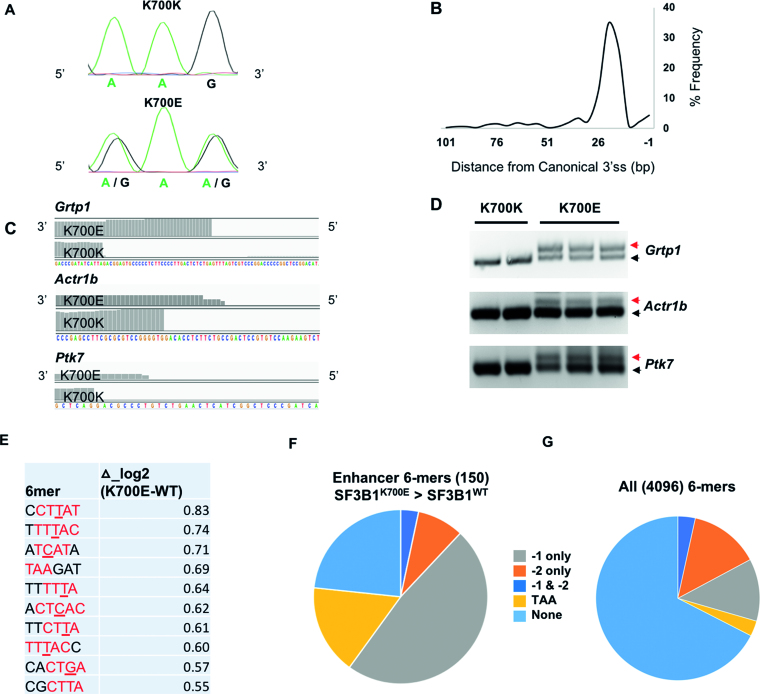
Generation of isogenic Sf3b1-mutant mouse embryonic stem cells (mESC) and confirmation of changes to BP usage. (A) Analysis of SF3B1 mRNA expression from edited alleles by Sanger sequencing of cDNA isolated from SF3B1K700K and SF3B1K700E mESC. (B) Distribution of the distances of cryptic 3′SS in relation to their canonical 3′SS are shown for Sf3b1K700E mESC, as determined by RNA-seq. (C) Cryptic 3′SS in three candidate genes identified through comparative anlaysis of RNA-Seq from SF3B1K700K and SF3B1K700E mESC clones. (D) Confirmation of cryptic 3′SS in Figure 5C by reverse transcription, PCR and gel electrophoresis. Red and black arrows represent isoforms associated with cryptic 3′SS and canonical 3′SS selection, respectively. (E) Splicing enhancing upstream 6-mer sequences (OR >1.5) in mESC datasets with highest difference between SF3B1WT and SF3B1K700E (Δ_log2_K700E-WT), as shown in Figure 3A. −3 to +1 positions relative to BP adenosine is colored red. Non-canonical nucleotides (varying from the canonical YTAAY sequence) at −1 position are underlined. (F) Distribution of 6-mers that enhance splicing (OR > 1.5) more in SF3B1K700E compared to SF3B1WT in mESC datasets (total of 150 6-mers met criteria). Motifs are divided to those that contain trinucleotide TAA, −1 position variants, −2 position variants, Variants at both −1 and −2 and those have none of the above. (G) Expected distribution of all 4096 6-mers to the same categories as described for 5F.